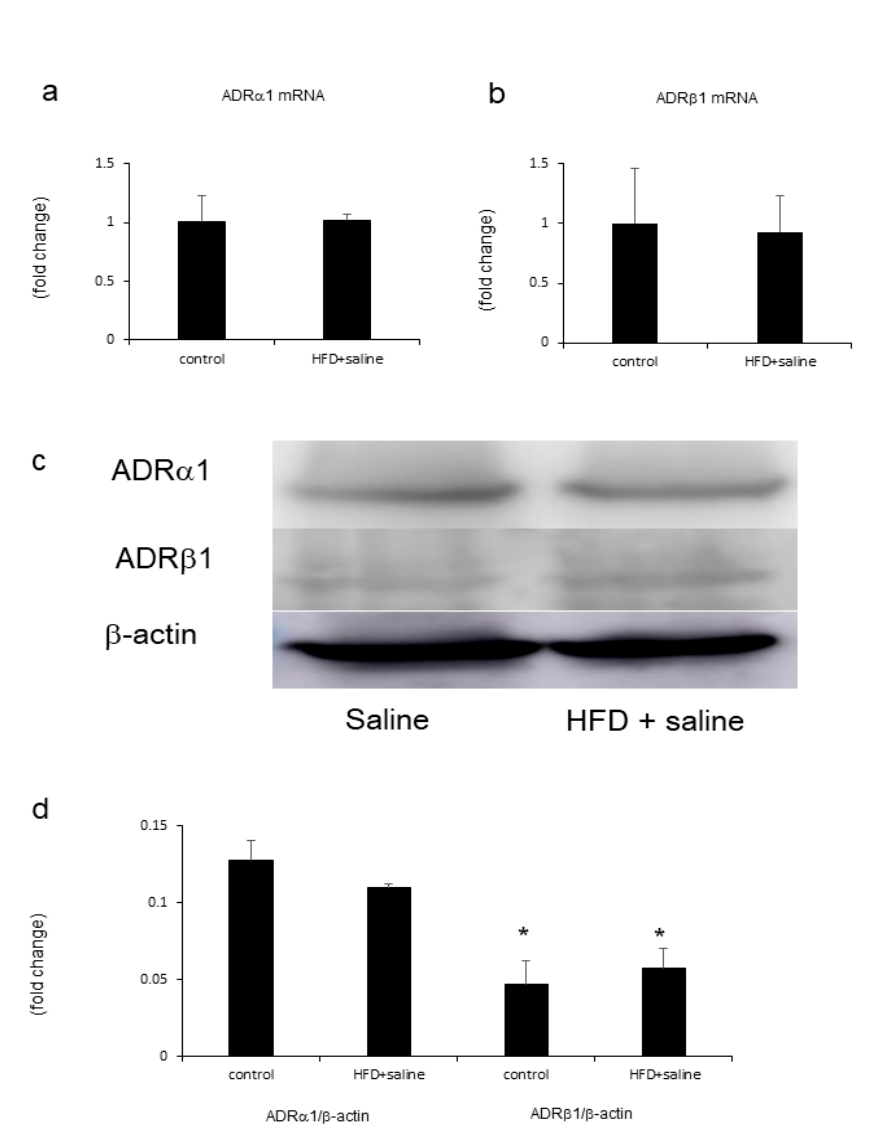
Figure 6. Evaluation of the mRNA expression of hepatic adrenergic receptors. ( b ). Relative mRNA expression levels of ADR α 1 ( a ) and ADR β 1 ( b ) were evaluated in the liver. Western blotting images ( c ) and levels ( d ) of ADR α 1 and ADR β 1 in the liver. Statistical analysis was performed using Student’s t -test or analysis of variance (ANOVA) from di ff erent treatment groups. Data are expressed as means ± SE. * p < 0.05 for ADR α 1 / β -actin compared to ADR β 1 / β -actin in the respective control and HFD with the saline group.